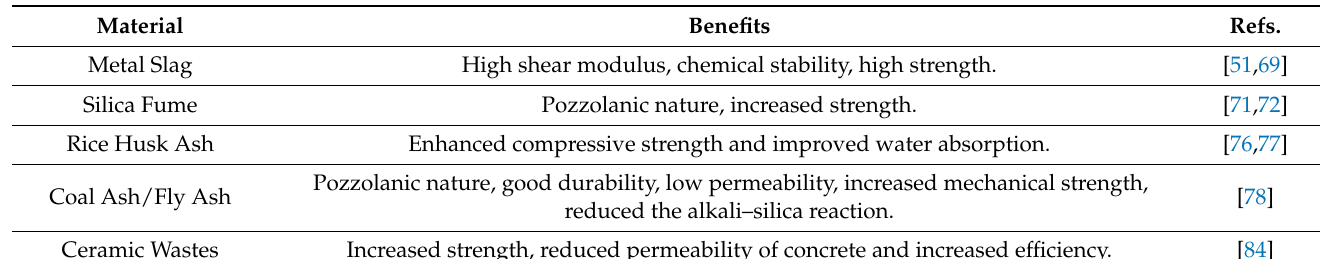
Table 2. Summary of various benefits of different wastes which can be incorporated as supplementary cementitious materials (SCMs) in concrete. Material Benefits Refs. High shear modulus, chemical stability, high strength. Pozzolanic nature, increased